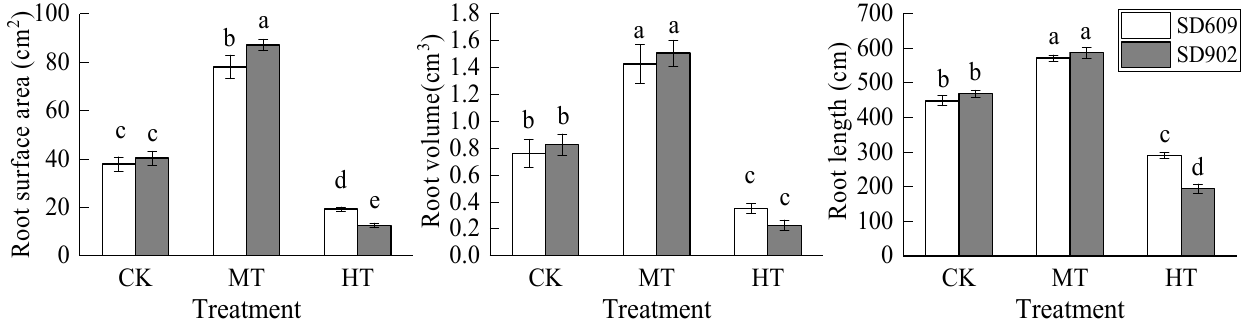
Figure 2. Effects of different root zone temperatures on root surface area, root volume, and root length of SD609 and SD902 maize varieties. CK: 24 ◦ C, MT: 30 ◦ C, HT: 36 ◦ C (root zone temperature). Notations above bars of a, b, c, d and e indicate homogeneous groups ( α = 0.05).